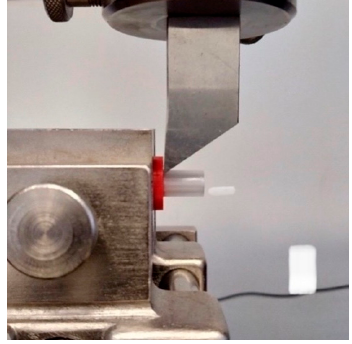
Figure 5. The setup for adhesion tests was performed using a shear test machine with a placed sample made of PLA as a bottom and TPU as a top cylinder.